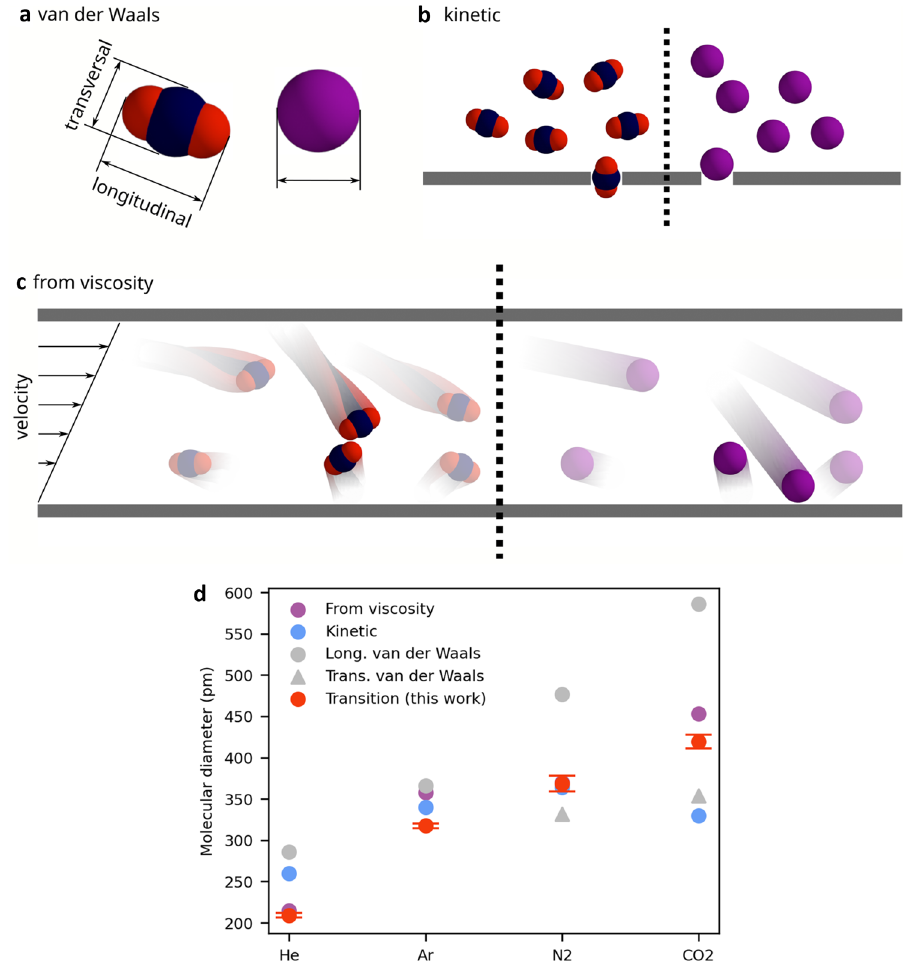
Figure 2. Compilation of molecular diameters for small gases. ( a ) The van der Waals diameter 5,6 has two definitions for an asymmetric molecule like carbon dioxide while a spherical gas like argon just has one. ( b ) Molecular sieve experiments yield the kinetic diameter 4 . Molecular shape can have a large influence on the result. Here, carbon dioxide can pass the sieve in the right orientation, while argon is too large. This results in a larger kinetic diameter for argon than for carbon dioxide. ( c ) Viscosity (ν) can be measured by the momentum exchange from one moving boundary to a stationary one. The momentum exchanges through diffusion from fast moving molecules (top) to slow moving molecules (bottom). This diffusion is limited by the mean free path. While the two highlighted carbon dioxide molecules collide because of their size, the argon molecules can pass. The larger the molecules, the slower the molecules can diffuse, resulting in lower measured viscosity 9 . This results in a larger viscous diameter for carbon dioxide than for argon. ( d ) Actual molecular sizes. Error bars show the two-sided prediction interval of 95%. The kinetic diameter of nitrogen and the diameter calculated from viscosity are covered by the transition diameter . The two van der Waals diameters for nitrogen and carbon dioxide are the transversal and the longitudinal ones. For numerical values, see Supplementary Table